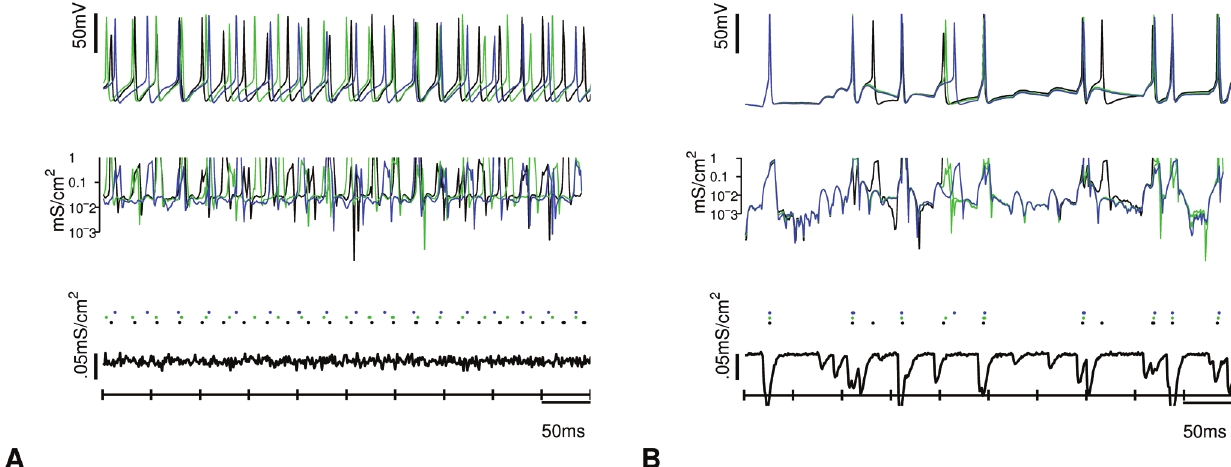
Figure 4. Input correlation-dependent read-out of intrinsic memory. Response to inputs generated from N = 80 neurons firing with 20Hz with independent Poisson processes using different correlation parameters W = 0.2, 0.9 ( A , B ). Extreme values of correlations have been chosen for demonstration purposes. Three slightly different neurons with µ As = 1.1,1.3,1.5 are shown under BOTH conditions. ( A ) Response modulation and different firing rates for each neuron (here: 20, 26, 40Hz) occur with distributed (low correlation) input. ( B ) Highly